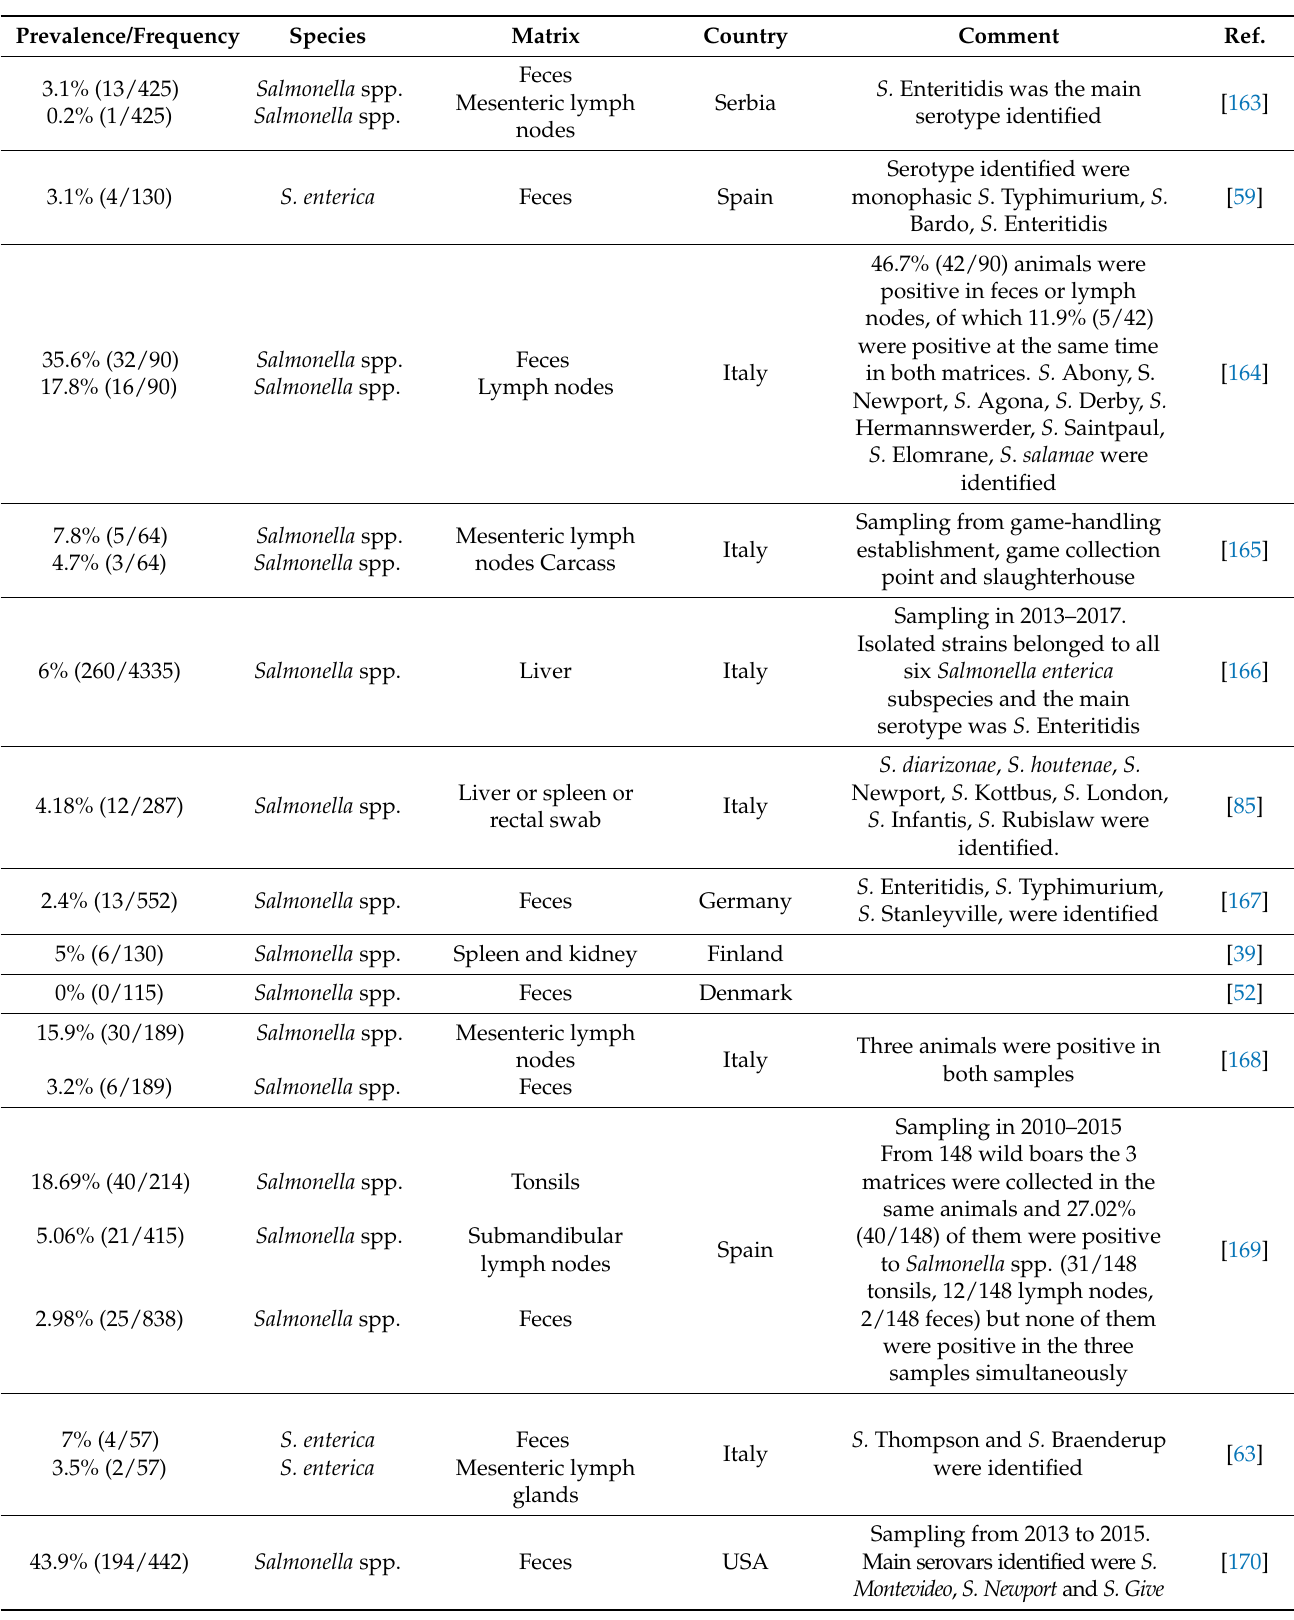
Table 9. Prevalence of Salmonella spp. in wild boar, feces, lymphatic tissues, and inner organs,